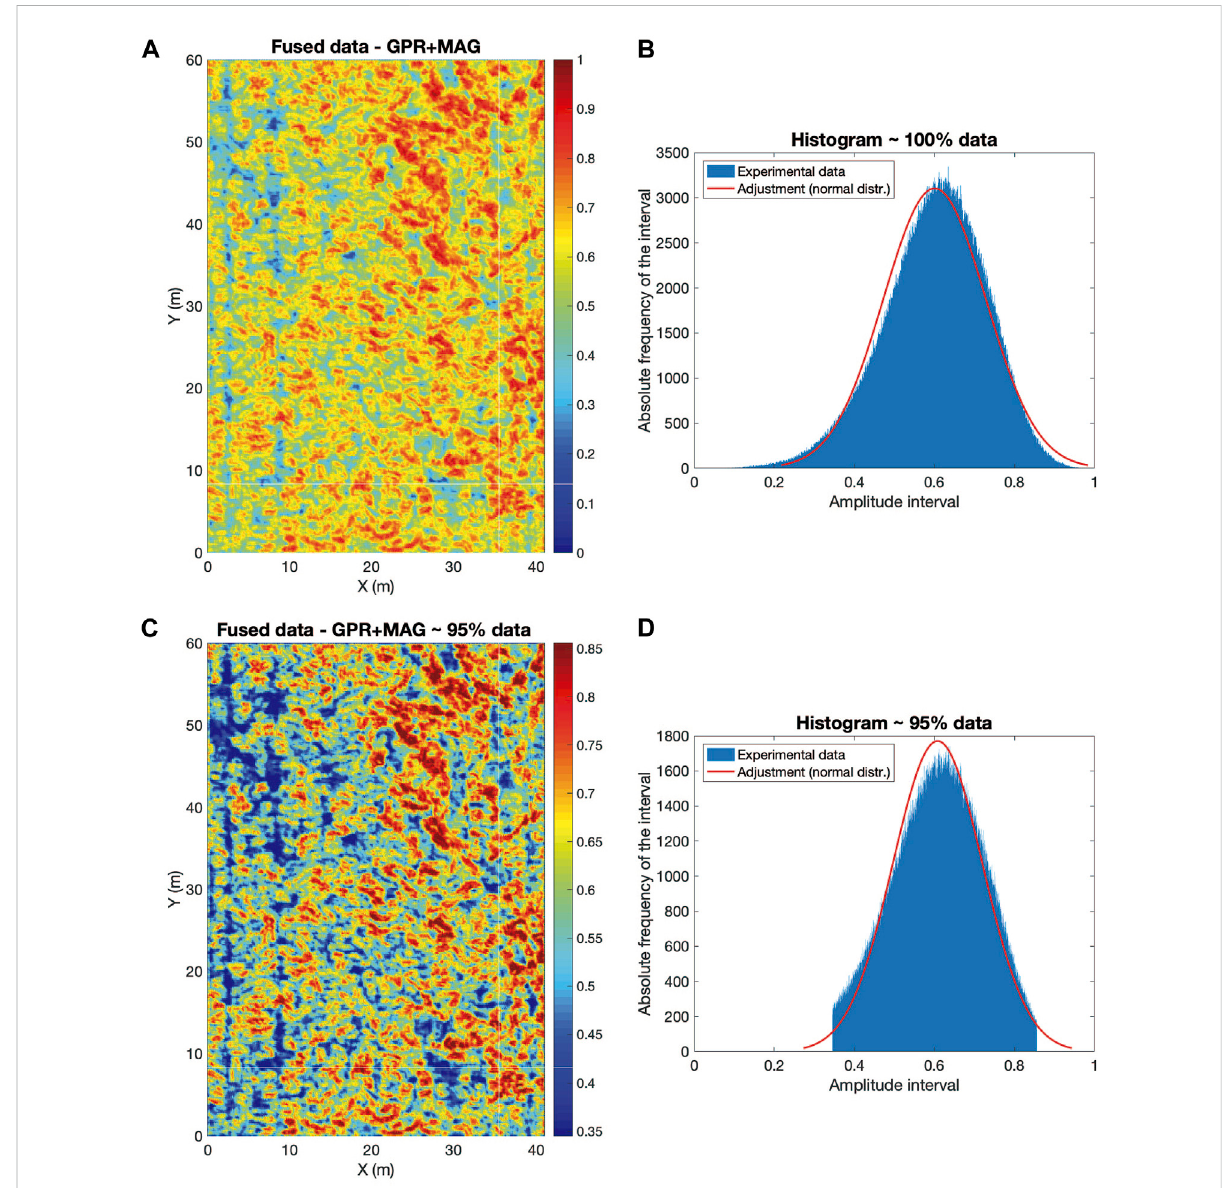
considered in (A)